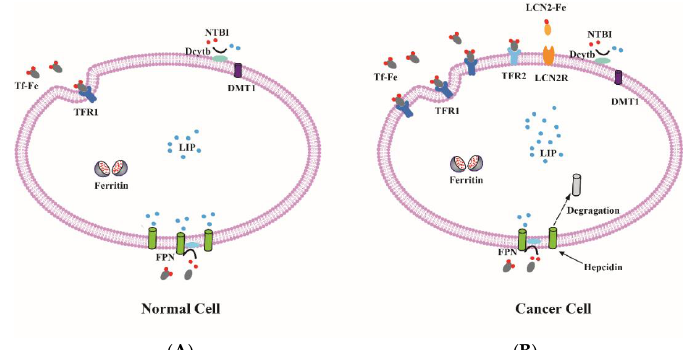
Figure 2. Iron metabolism in normal and cancer cell. ( A ) The expression of iron uptake proteins, such as TFR1, TFR2 and DMT1 are low, and the expression of iron export protein FPN is high in normal cells, resulting in a low level of labile iron; ( B ) By contrast, some cancer cells often have elevated TFR1, TFR2 and LCN2 as well as low FPN expression. Therefore, these cancer cells can increase intracellular iron to maintain the high demand for iron.